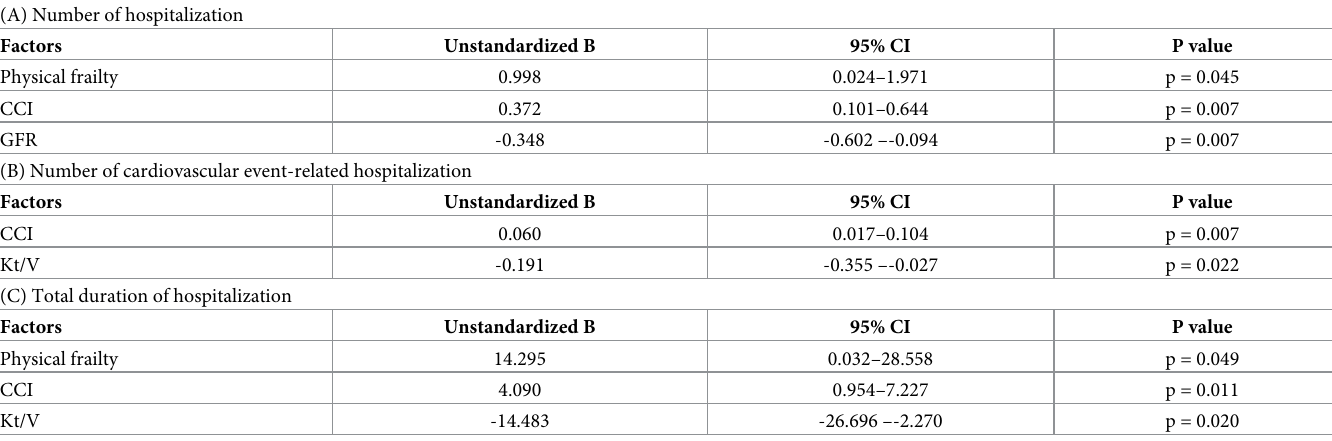
Table 5. Multivariate linear regression analysis of hospitalization after log